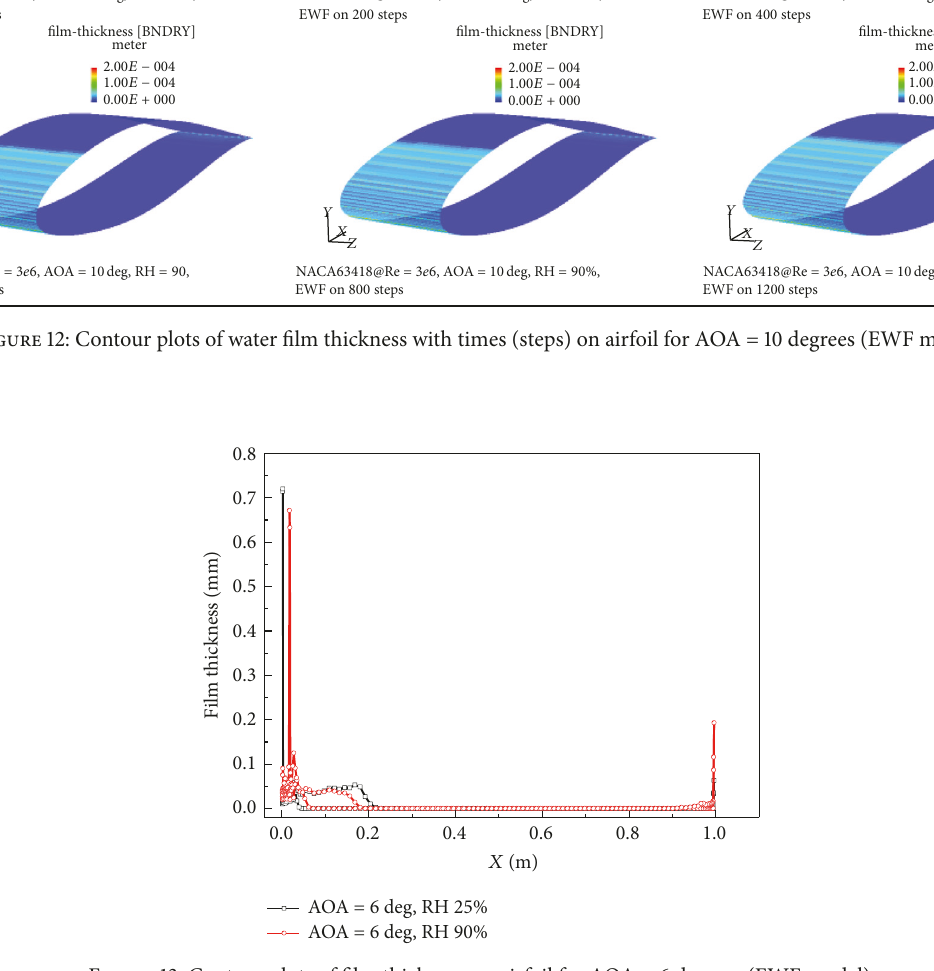
Figure 13: Contour plots of film thickness on airfoil for AOA = 6 degrees (EWF